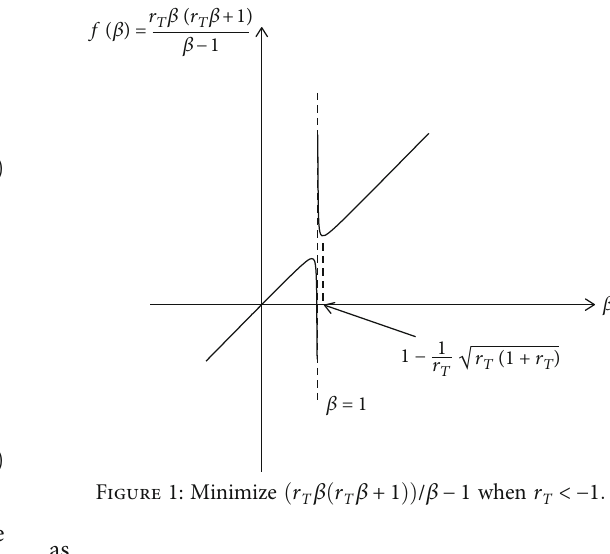
β ð r β + 1 ÞÞ / β − 1 when r T T